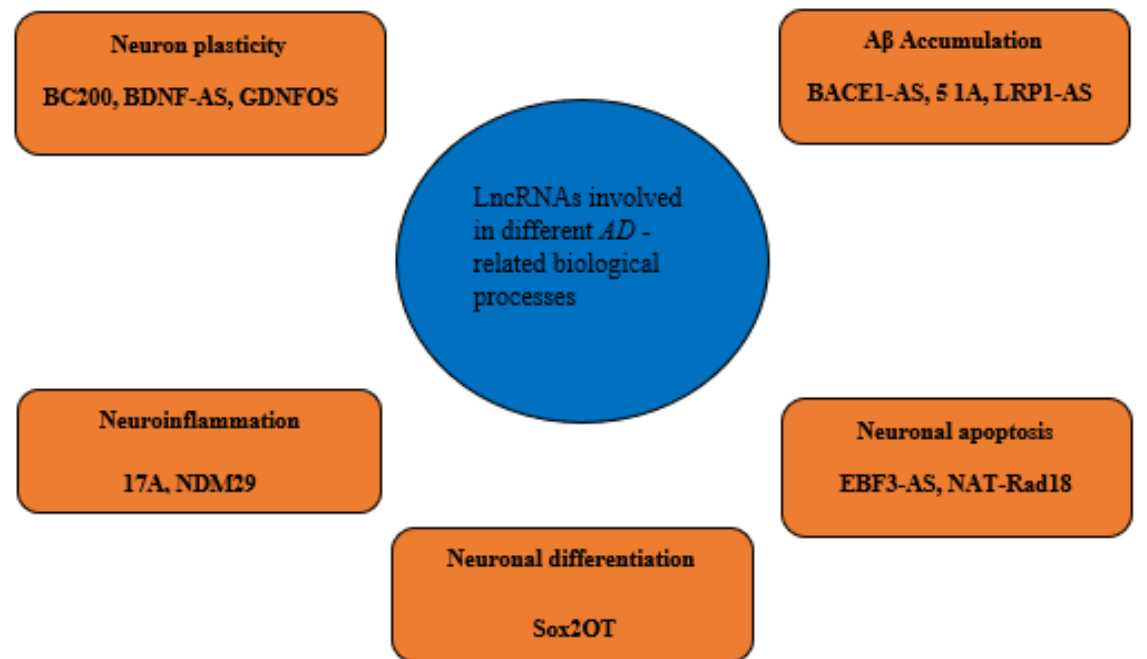
Figure 2: LncRNAs involve in different pathological aspects of Alzheimer’s disease. Each AD-related lncRNA is grouped according to the involved AD-leading pathological